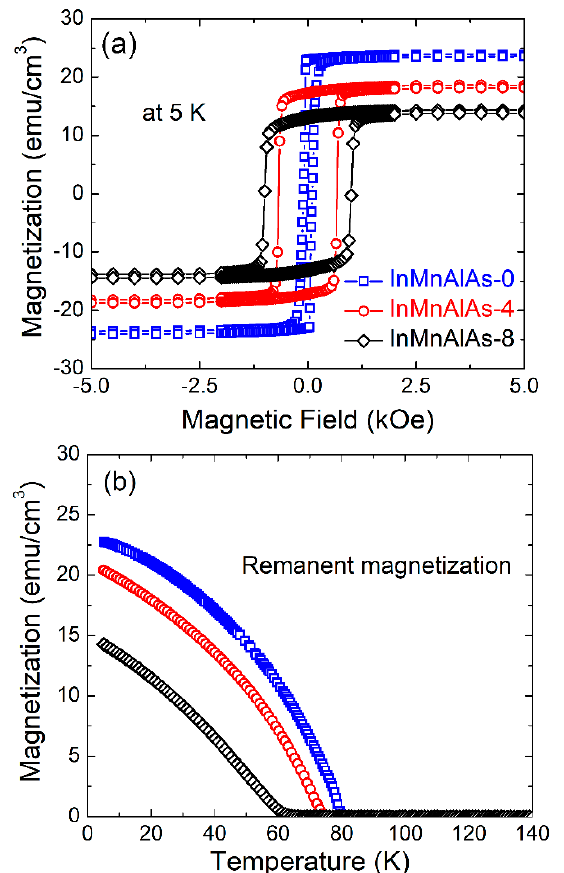
Figure 4. ( a ) Magnetic field dependent magnetization of the InMnAlAs-0 (squares), InMnAlAs-4 (circles), and InMnAlAs-8 (diamonds) samples, at 5 K, when the magnetic field is applied along the out-of-plane direction; ( b ) temperature dependent remanent magnetization at zero field of three samples.